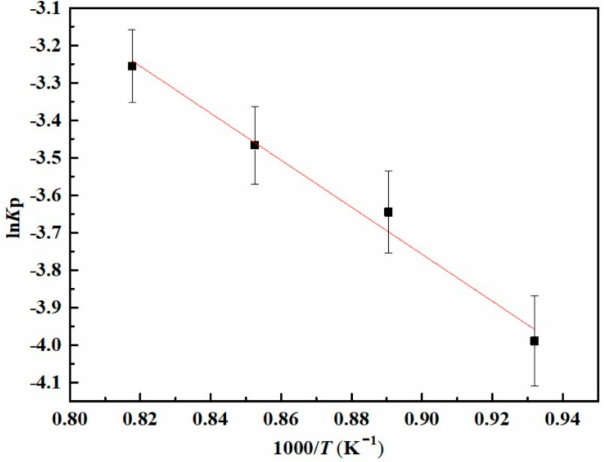
Figure 10. Graph of dependence of the parabolic oxidation rate constant from temperature for Al coatings.